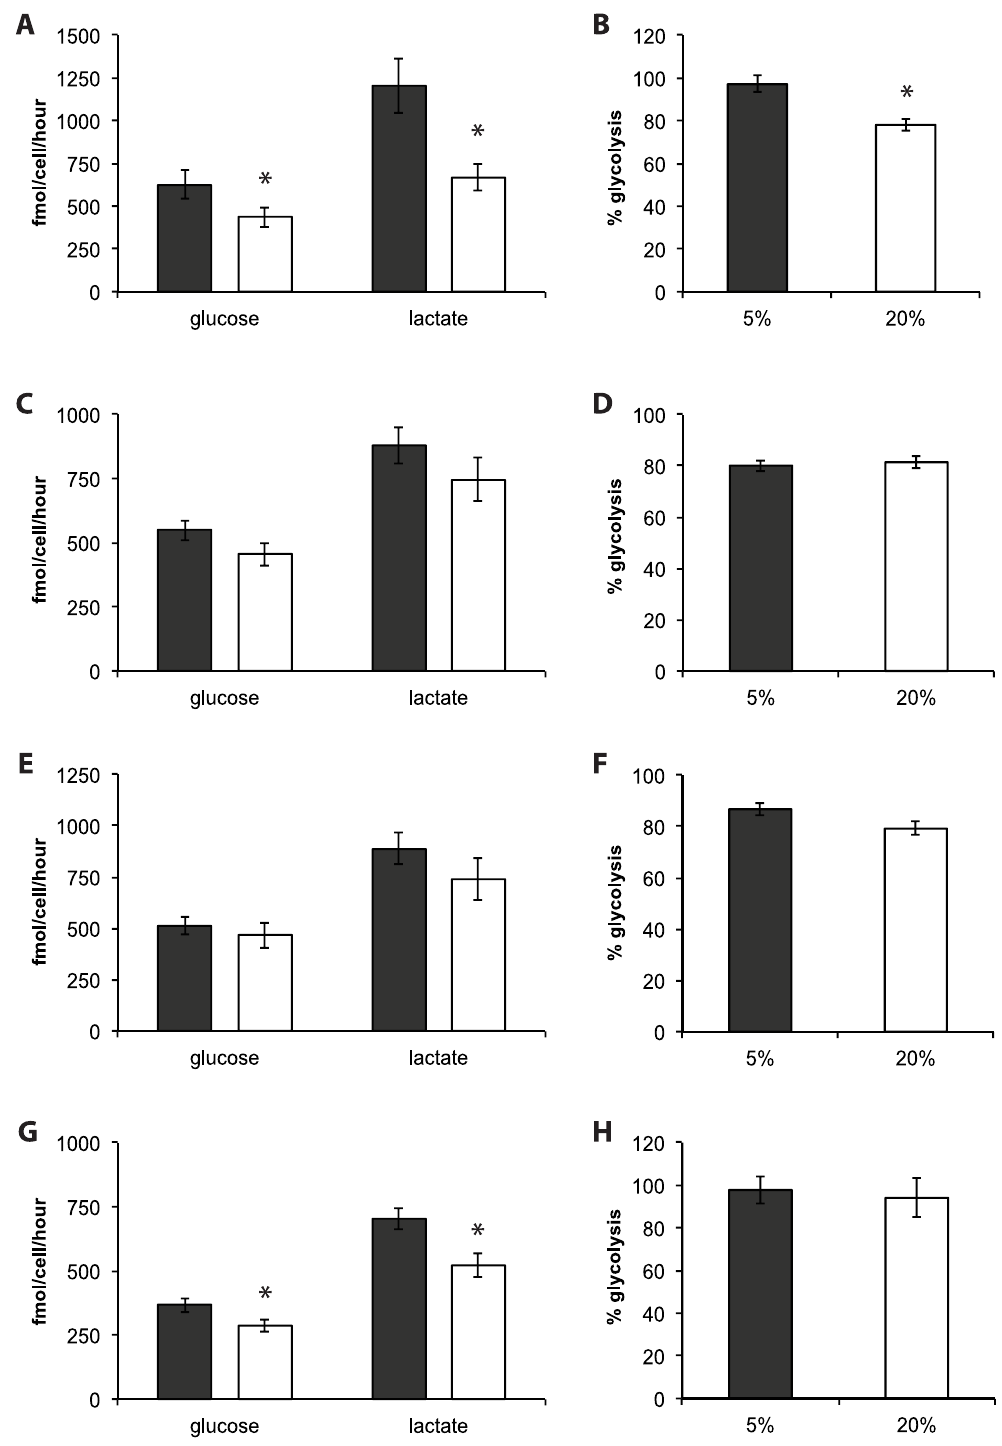
Fig 4. Carbohydrate utilisation and percentage glycolysis in MEL1 human ES (A, B), PDL (C, D), NHF1.3 (E, F) and IMR90 (G, H) human iPS cells in response to oxygen. ( A, C, E, G ) Glucose consumption and lactate production, quantified in spent medium samples by 1 H-NMR, normalised to cell number and an internal standard (imidazole). ( B, D, F, H ) Glycolytic rate (% glycolysis) for each cell line was calculated as the number of moles of lactate / 2 x number of moles of glucose. Black bars: 5% oxygen; white bars: 20% oxygen. Data are presented as mean ± SEM; n = 8 samples per line per treatment. (cid:3) P < 0.05, (cid:3)(cid:3) P < 0.01.